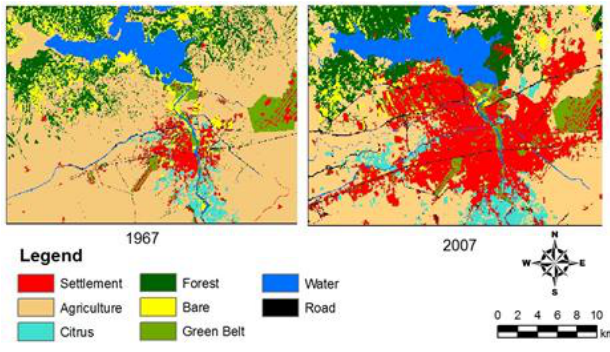
Figure 2. Object-based classification results.